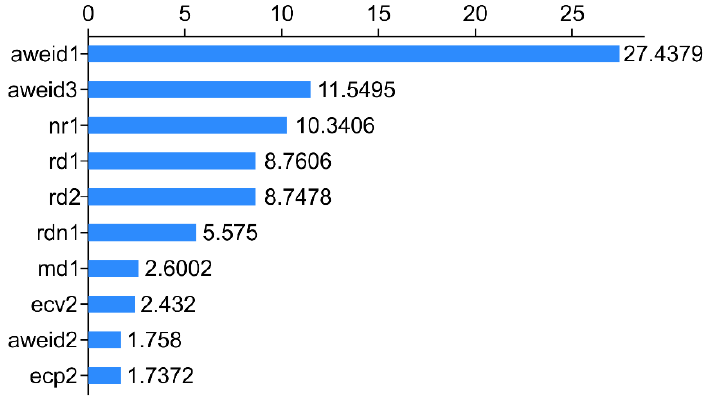
Figure 2. Importance of features for the ten variables in decision tree classification.